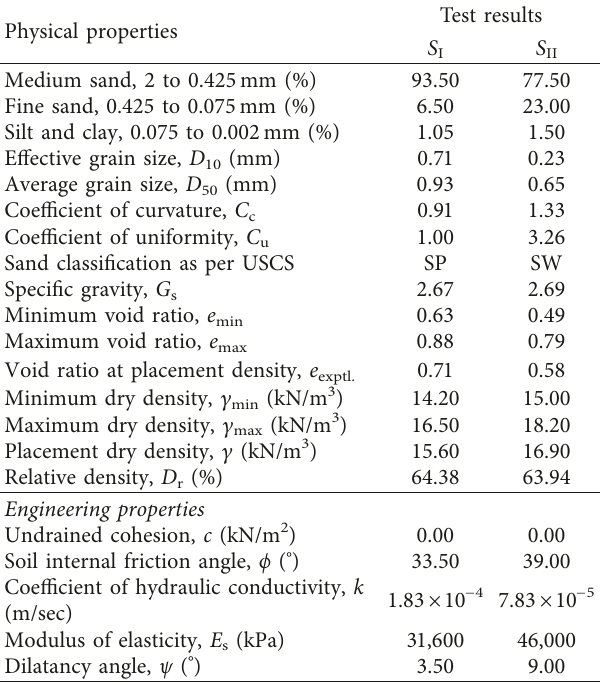
Table 1: Properties of sand I ( S